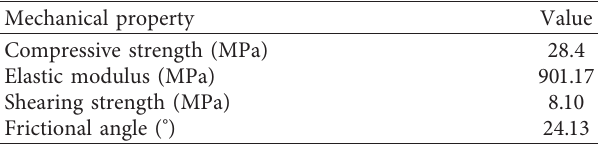
Table 9: Mechanical properties of